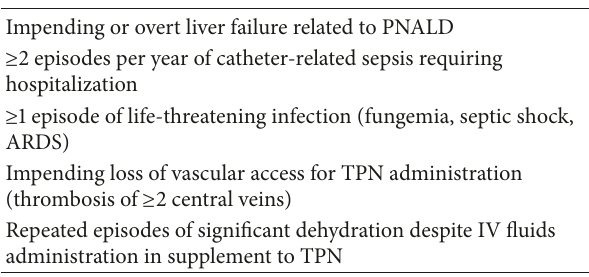
Table 1: TPN-related complications warranting intestinal trans- plantation (Medicare and Medicare